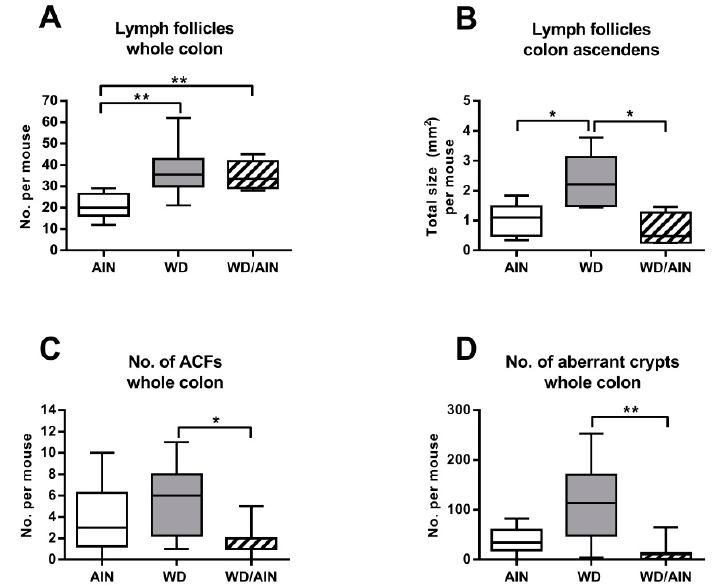
Figure 3. Effect of the diet on the (A) number ( n = 7–8), and (B) size of colonic lymph follicles ( n = 4– 5), ANOVA with Tukey post-hoc test. Effect of the diet on (C) number of aberrant crypt foci (ACFs), ANOVA with Tukey post-hoc test on log transformed data ( n = 7–8). Effect of the diet on the (D) number of aberrant crypts ( n = 7–8), Kruskal Wallis with Dunn post-hoc test; median,